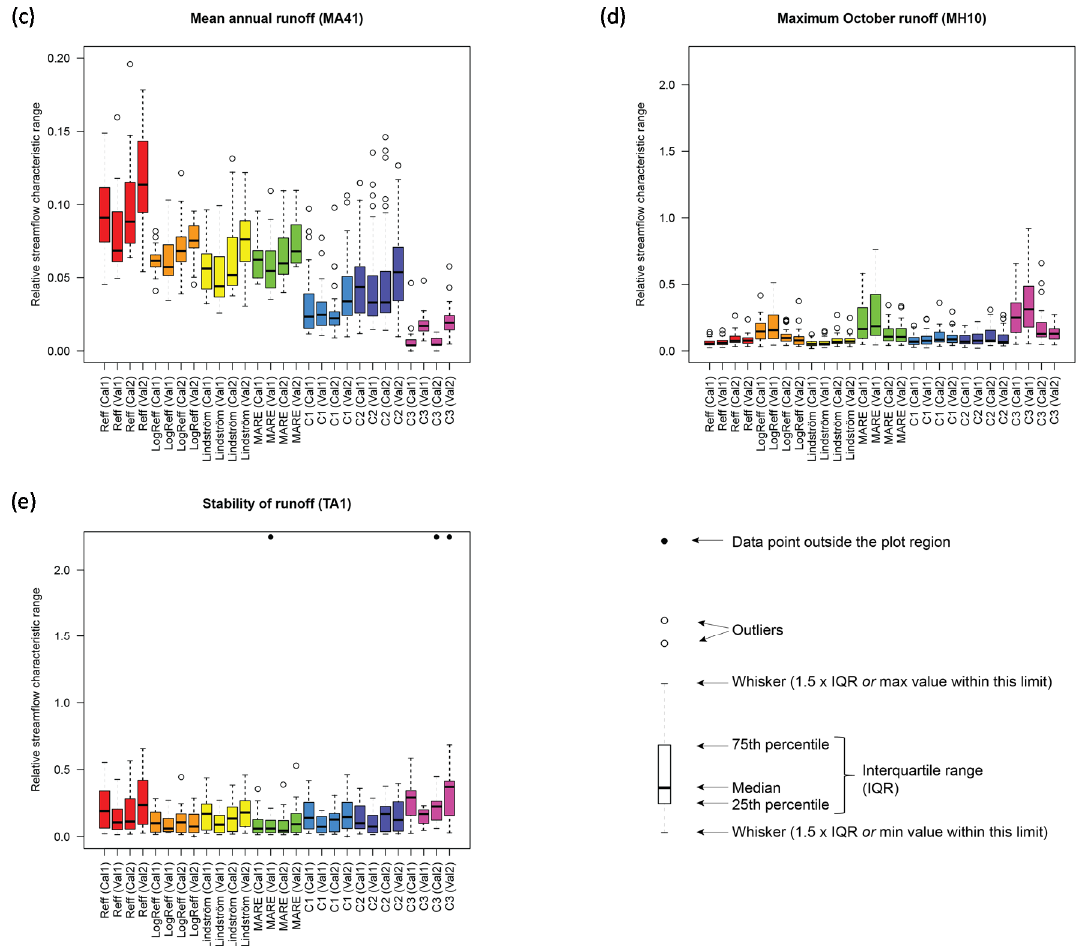
Figure 4. Relative ranges as a measure for parameter uncertainty for streamflow characteristics ( a ) DH16 (Variability in high-flow pulse duration); ( b ) FL2 (Variability of low-flow pulse count); ( c ) MA41 (Mean annual runoff); ( d ) MH10 (Maximum October runoff) and ( e ) TA1 (Stability of runoff). Each color corresponds to an objective function. Per objective function, the four boxplots represent (from left to right) calibration period 1 (Cal1), validation period 1 (Val1), calibration period 2 (Cal2) and validation period 2 (Val2). Each boxplot is based on 27 values, one value for each of the 27 catchments. Relative ranges were computed by dividing the range over the 100 runs per catchment by the range over the 27 median catchment values. Note that the Mean annual runoff (MA41) has been plotted on a different